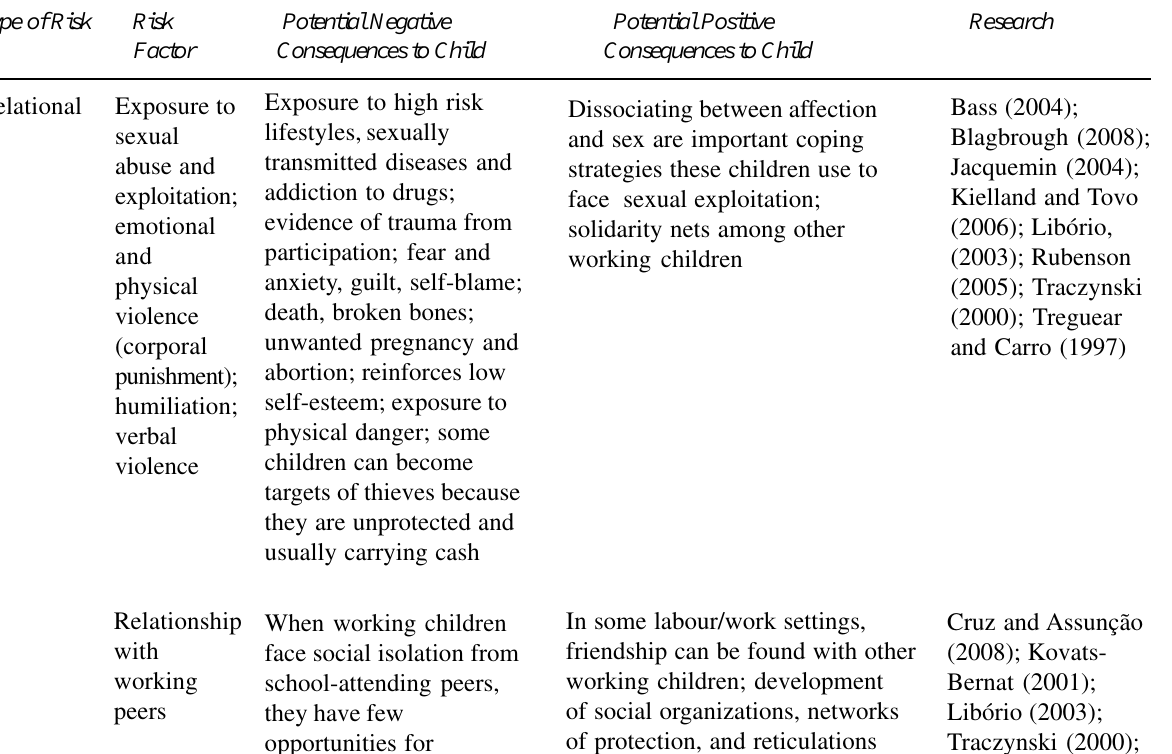
Table 2 Relational Risks and Potential Negative and Positive Consequences Associated with Children’s Labour/Children’s Work Type of Risk Potential Negative Potential Positive Research Consequences to Child Consequences to